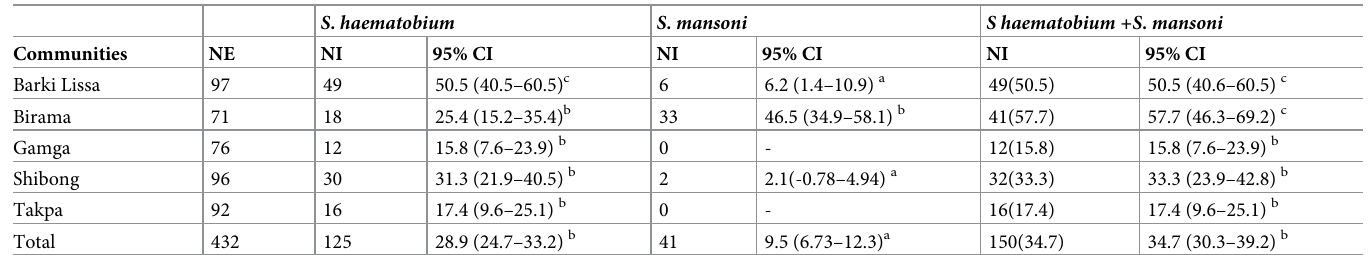
Table 2. Prevalence of schistosomiasis among the study participants.